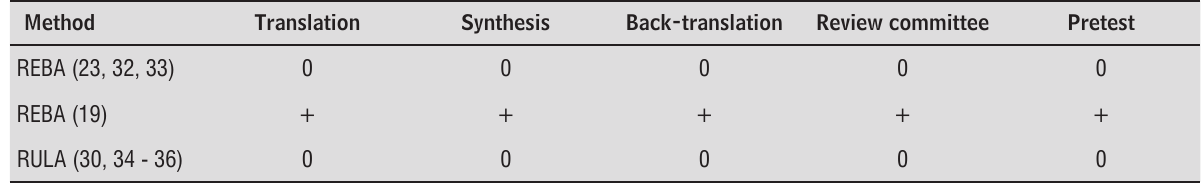
Table 3 - Analysis of translation and cross-cultural adaptation procedures of observational methods according to Guide- lines for the Translation and Cross-Cultural Adaptation of Questionnaires